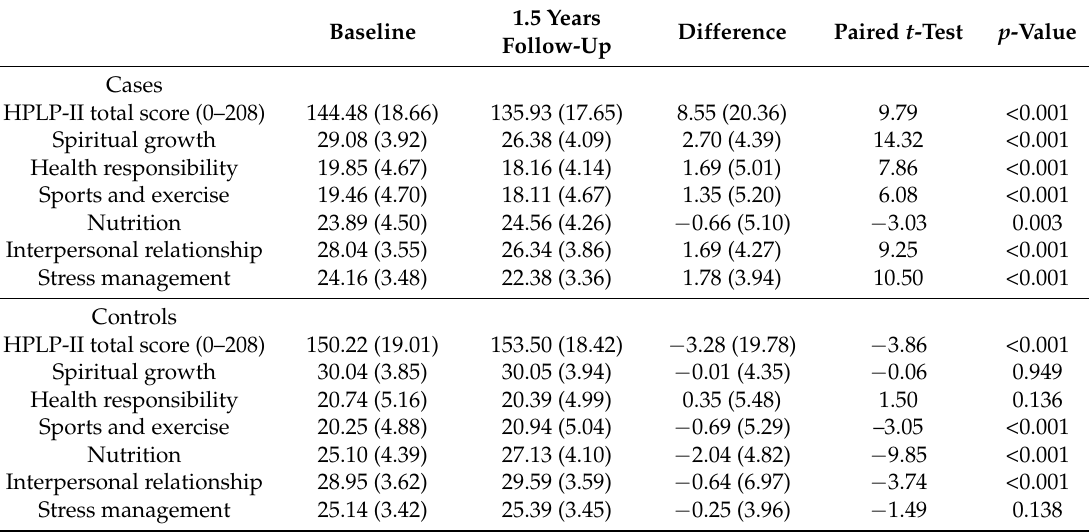
Table 3. Health-promoting lifestyle behaviors assessment by HPLP-II at baseline and at 1.5 years follow-up in cohort of college students participating in the study.